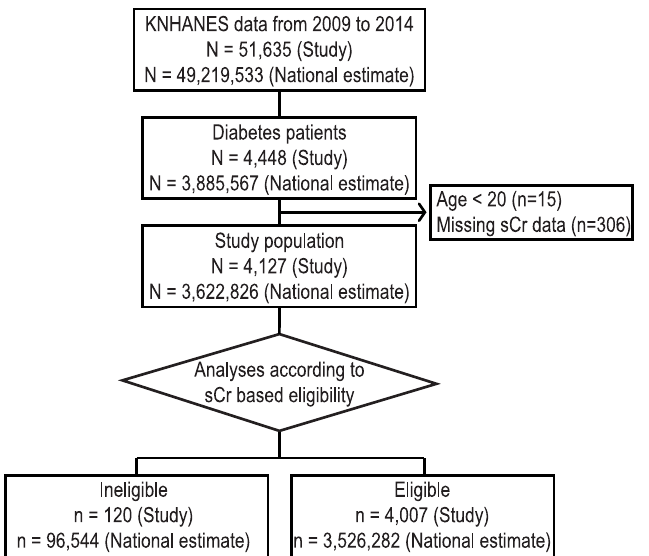
Fig 1. Flow diagram of study selection. KNHANES, Korea NationalHealth and NutritionExamination Survey; sCr, serum creatinine.“Study” refers to actual study participants’ data. “Nationalestimate” refers to representative populationestimates of the total Korean